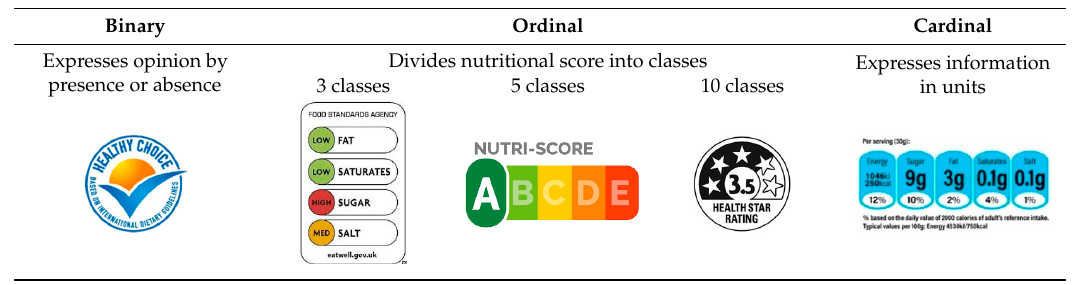
From left to right: Choice Logo, Multiple Traffic Lights (simplified version), Nutri-Score, Health